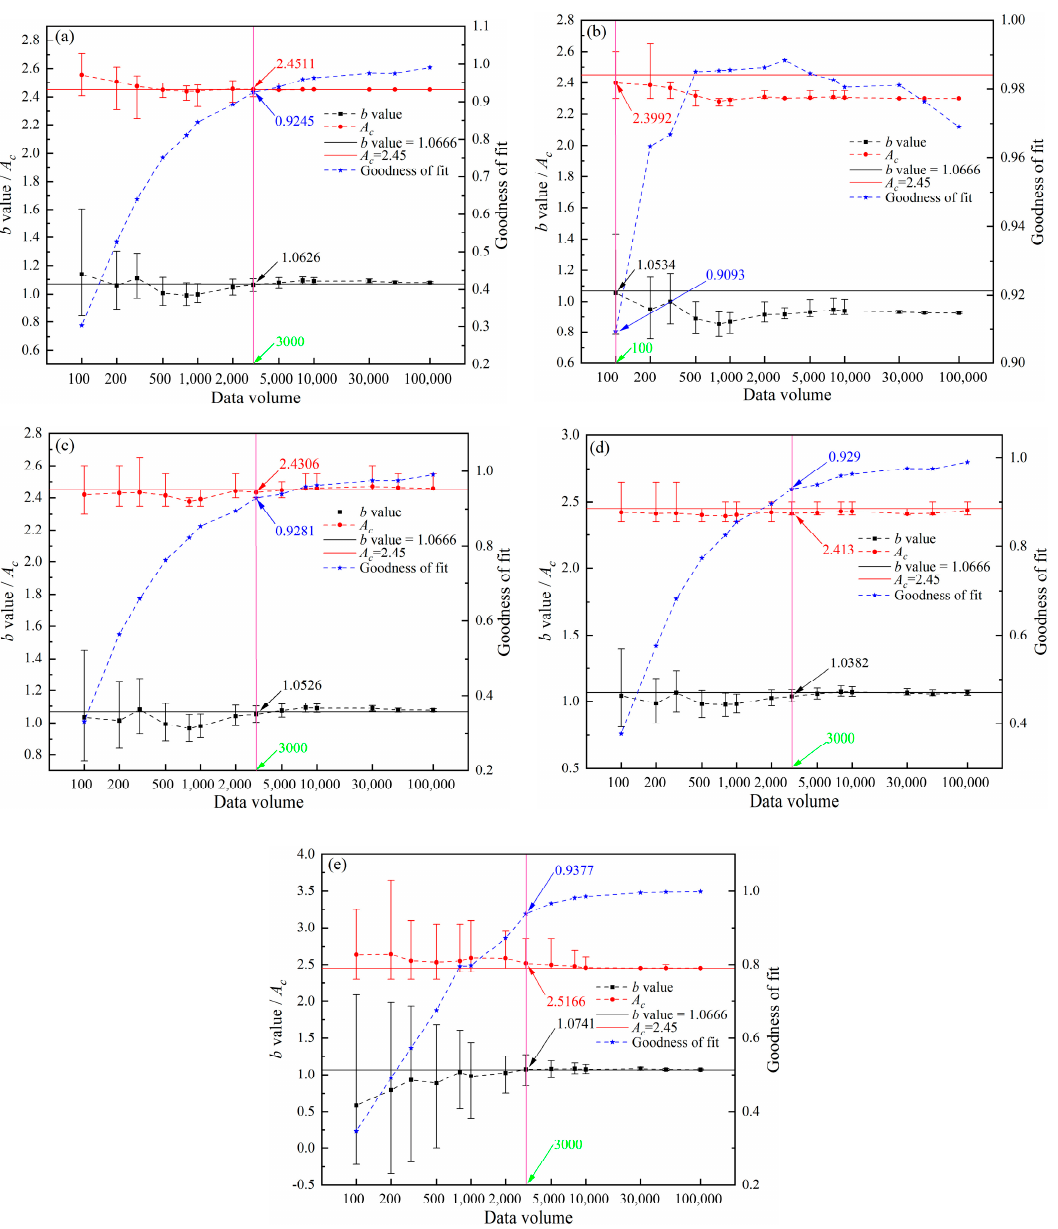
Figure 3. The variation of A c and b values estimated by the five methods with different synthetic data volumes. The theoretical A c value is 2.45, theoretical b value is 1.0666, and the data volume is 100,000. Estimated A c and b values are the mean value of 1000 Bootstrap samples. The error bar is the 95% Bootstrap confidence limit. ( a – e ) MAXC, GFT-90%, MBS, MBASS, and FGS, respectively.